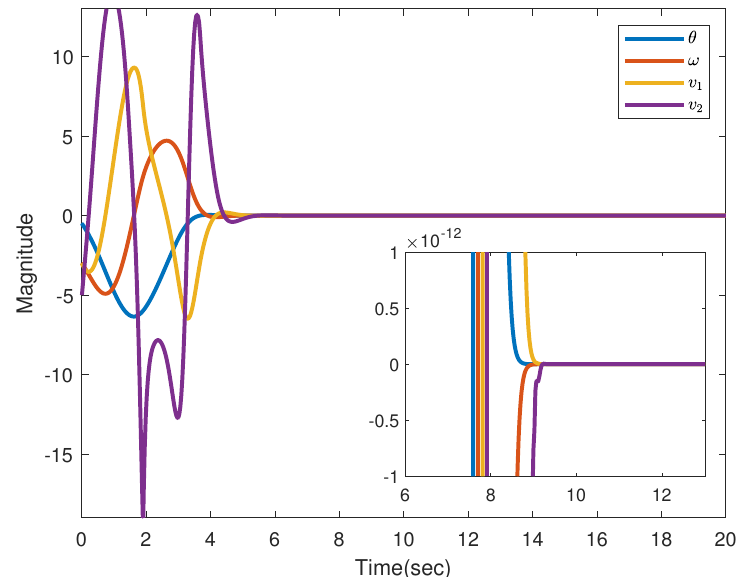
Figure 2. Convergence of the states of the system (5) to the